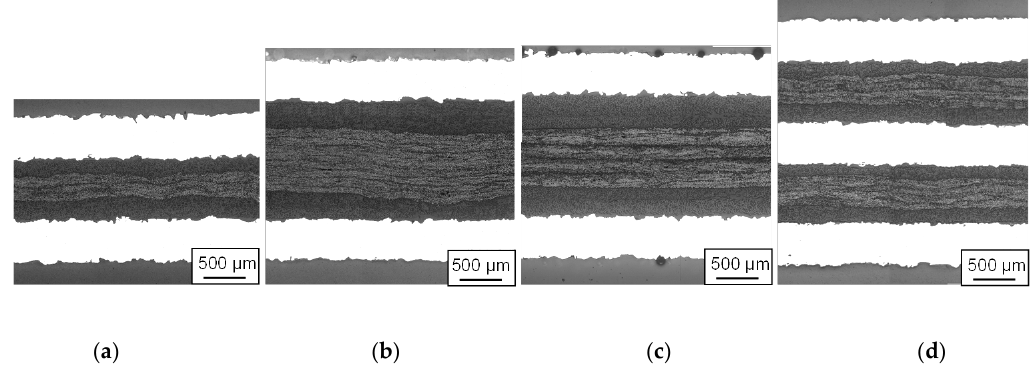
Figure 7. Cross section of hybrid laminates: ( a ) 2/1 (GC), ( b ) 2/1 (GGCC), ( c ) 2/1 (G ′ G ′ CC), and ( d ) 3/2 (GC).